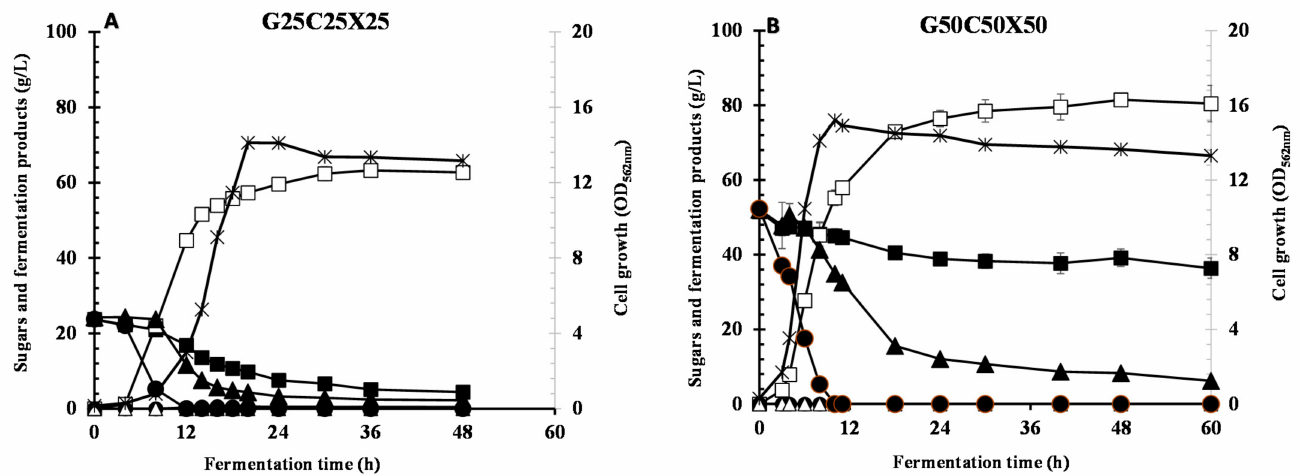
Figure 4. Effect of different glucose/cellobiose/xylose concentrations on growth and lactic acid production by B. coagulans Azu-10. ( A ) fermentation of 25 g/L glucose, 25 g/L cellobiose, and 25 g/L xylose [G25C25X25]; ( B ) fermentation of 50 g/L glucose, 50 g/L cellobiose, and 50 g/L xylose [G50C50X50]. Symbols: • , glucose (g/L); (cid:4) , cellobiose (g/L); (cid:78) , xylose (g/L); (cid:3) , lactic acid